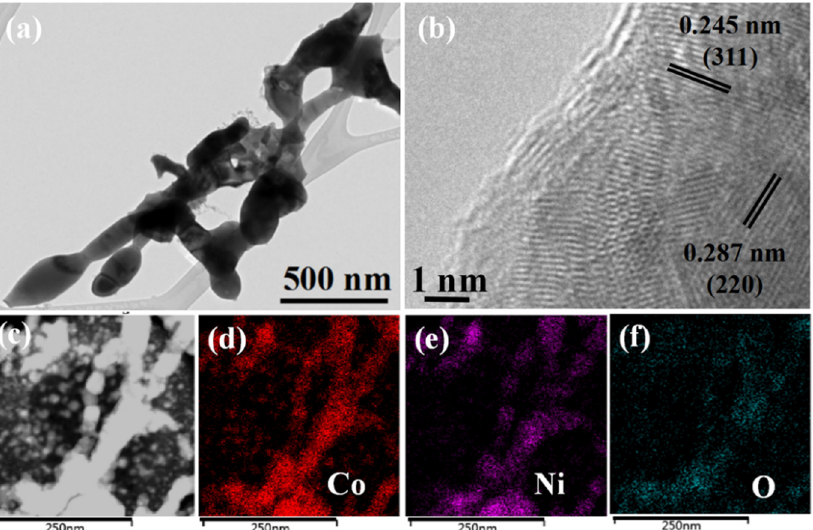
Figure 2. Low ( a ) and high ( b ) resolution transmission electron microscopy (TEM) images of NiCo 2 O 4 annealed at 700 °C, scanning transmission electron microscopy (STEM) image ( c ), and energy dispersive X-ray analysis (EDX) mapping of NiCo 2 O 4 ( d – f ).